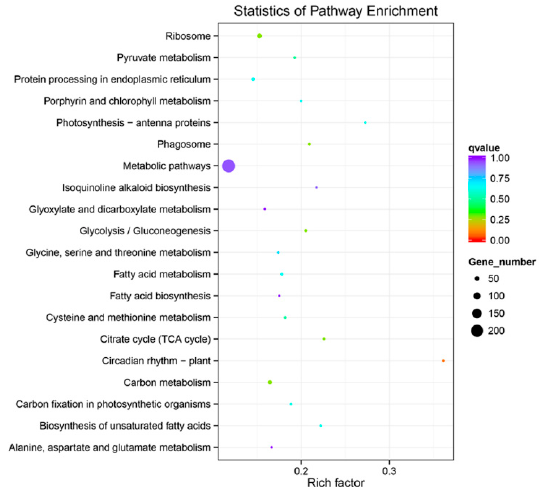
Figure 4. Gene ontology (GO) classification of differentially expressed (DE) mRNA corresponding genes in the cultivar “Huoche” under heat stress. The ordinate is the enriched GO term, and the abscissa is the number of differentially expressed genes in this term. Different colors are used to distinguish biological processes, cellular components, and molecular functions.